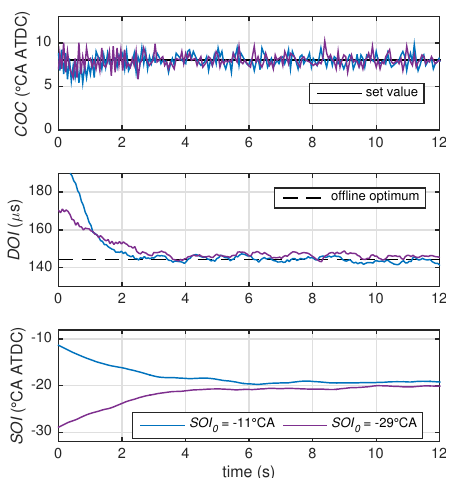
Figure 10. Two experimental results of the proposed extremum seeking method, i.e. , the fast excitation approach shown in Figure 9, at a constant operating point (see Table 2). The start of injection SOI is once initialized at − 29 ◦ CA ATDC and once at − 11 ◦ CA ATDC. The start of injection SOI is shown without the excitation signal.